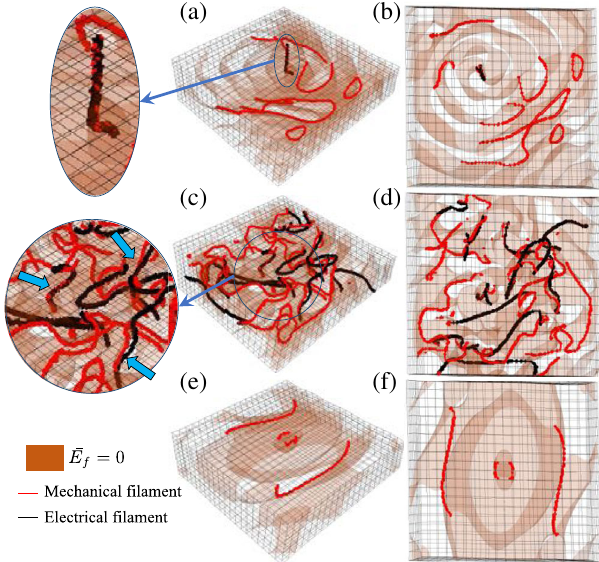
FIG. 11. Organization of electromechanical filaments in the presence of fiber rotation: (a),(b) Single electrical scroll wave. (c), (d) Composition of multiple scroll waves due to electrical wave break. (e),(f) Focal wave pattern after application of a pulse at the center of the top surface. The isosurface is presenting ¯ E ¯ E 0 , where ¯ E is the normalized strain along the fiber. f ¼ xx ¼ f Insets show colocalized electromechanical filaments. In the case that electrical waves remain stable, one can see a clear coloc- alization between mechanical and electrical filaments. However, as scroll waves break, a more complex mechanism can be observed, but many of electrical filaments are still paired with a mechanical